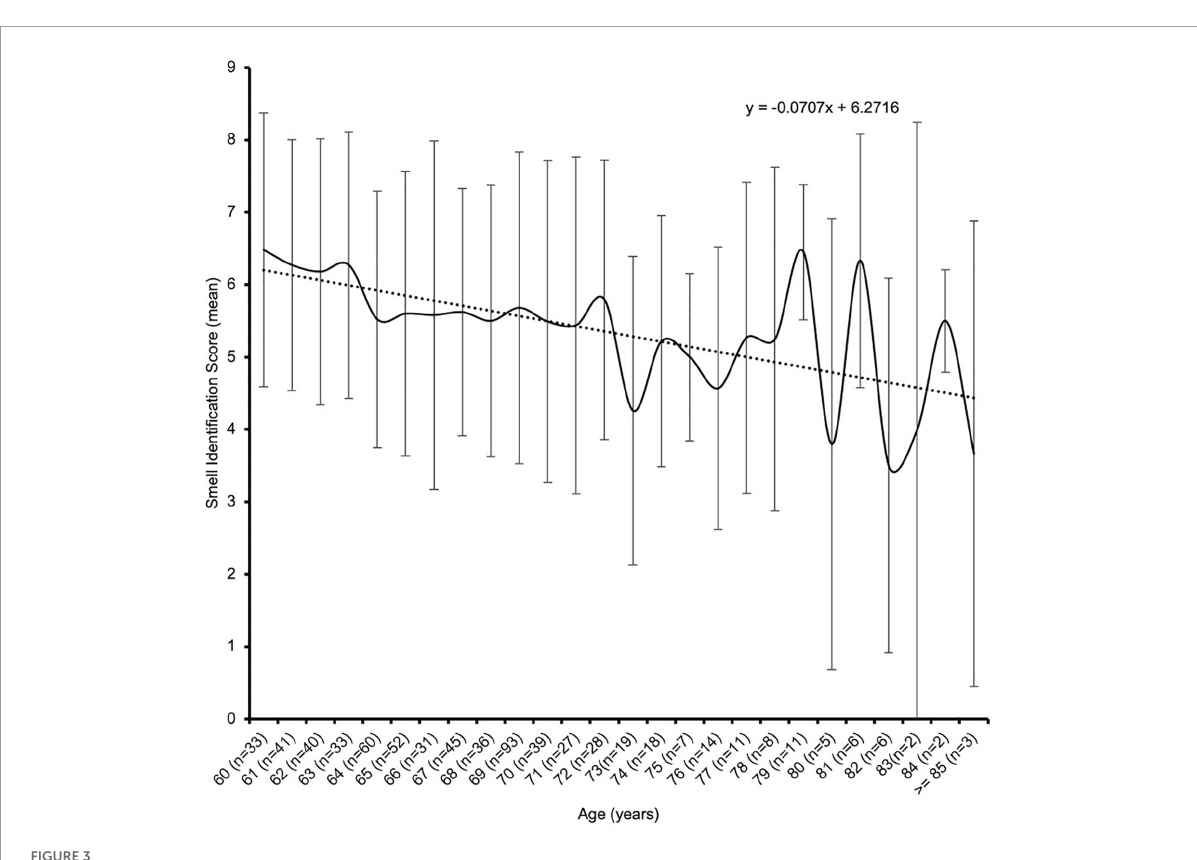
FIGURE3 Age-related smell identification score of 670 older